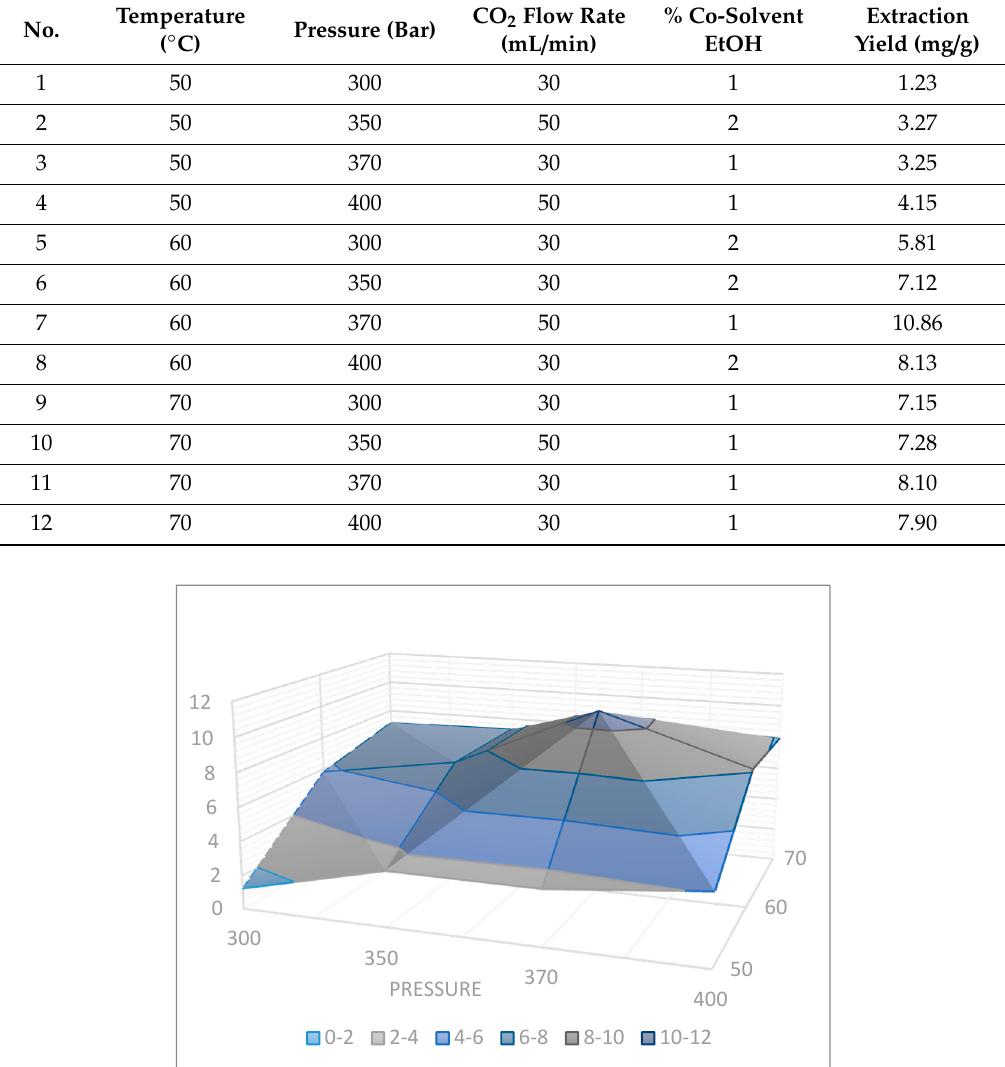
Table 2. Extraction yield of Rh. adamsii presented depending on operational parameters (pressure, temperature, CO2 flow rate, % co-solvent).